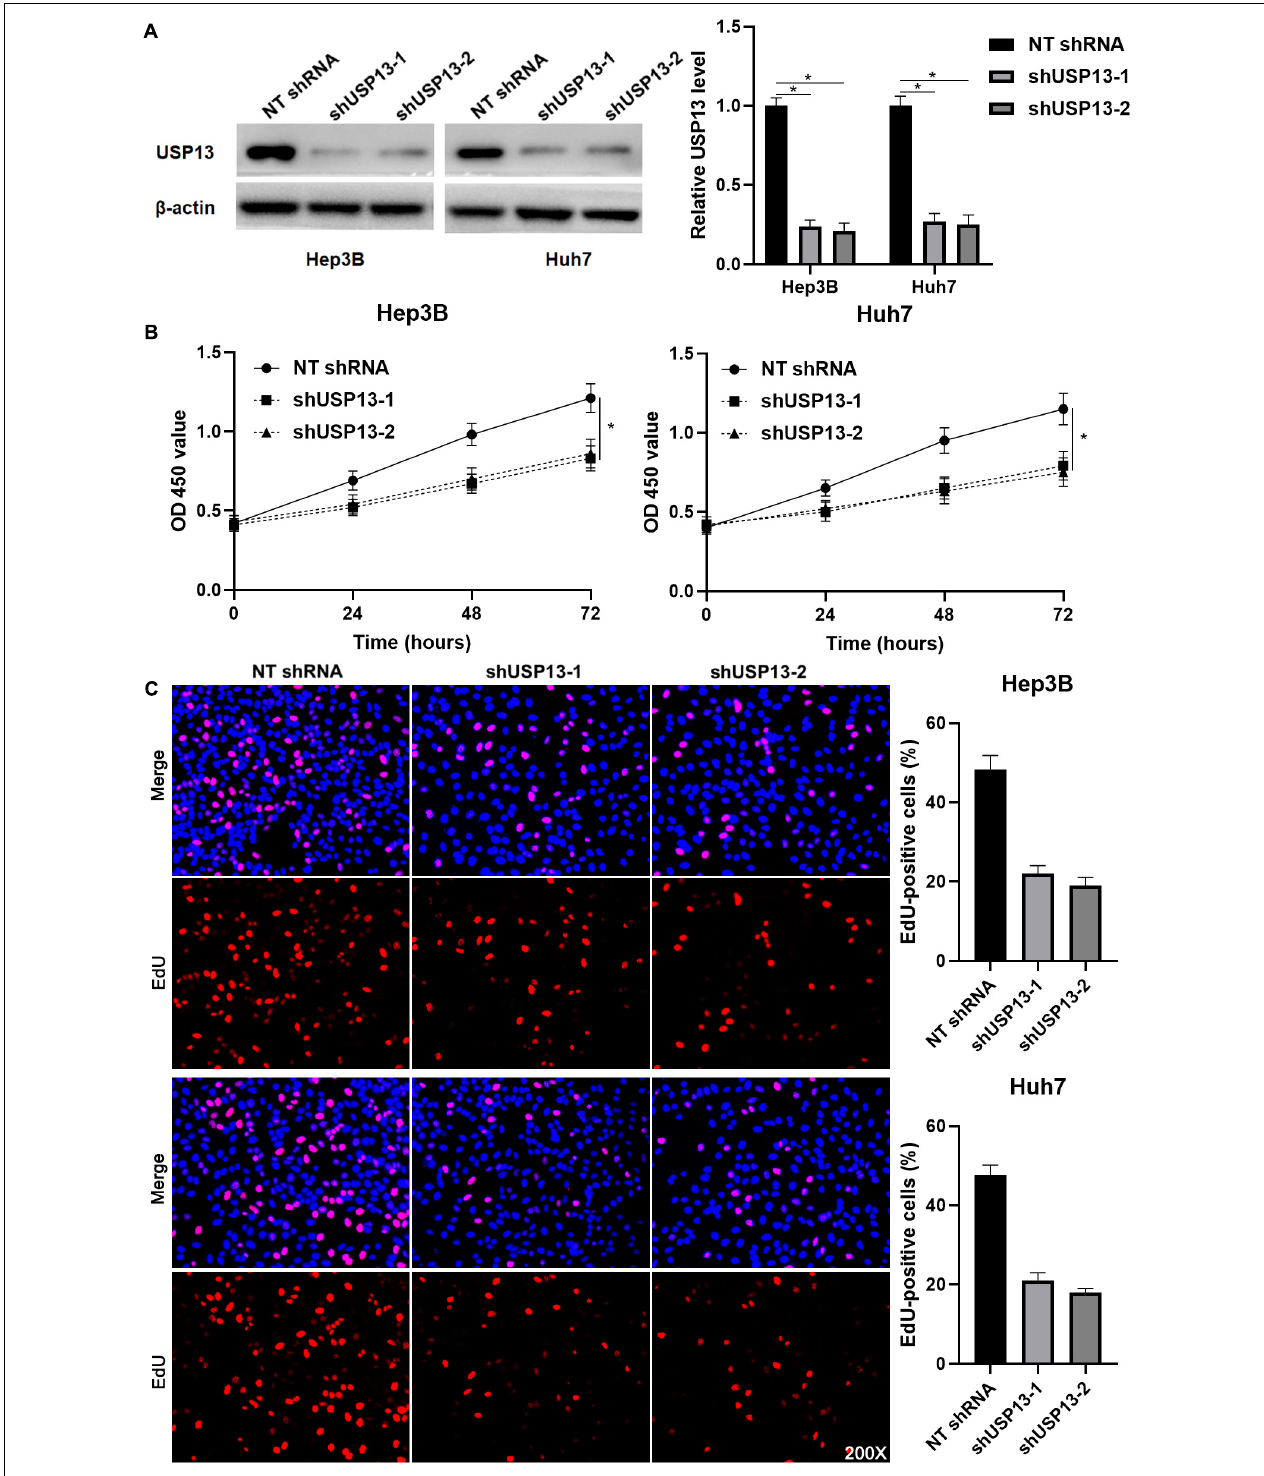
FIGURE 2 | USP13 knockdown inhibits the proliferation of HCC cells. (A) Hep3B and Huh7 cells were transfected with non-targeting (NT) shRNA and USP13 shRNAs (shUSP13-1 and shUSP13-2), respectively, and detected by western blot (WB) for USP13 expression. (B) CCK-8 assay indicated that USP13 silencing significantly reduced the viability of HCC cells. (C) The silencing of USP13 repressed the proliferation of HCC cells as suggested by EdU assay. * P < 0.05.